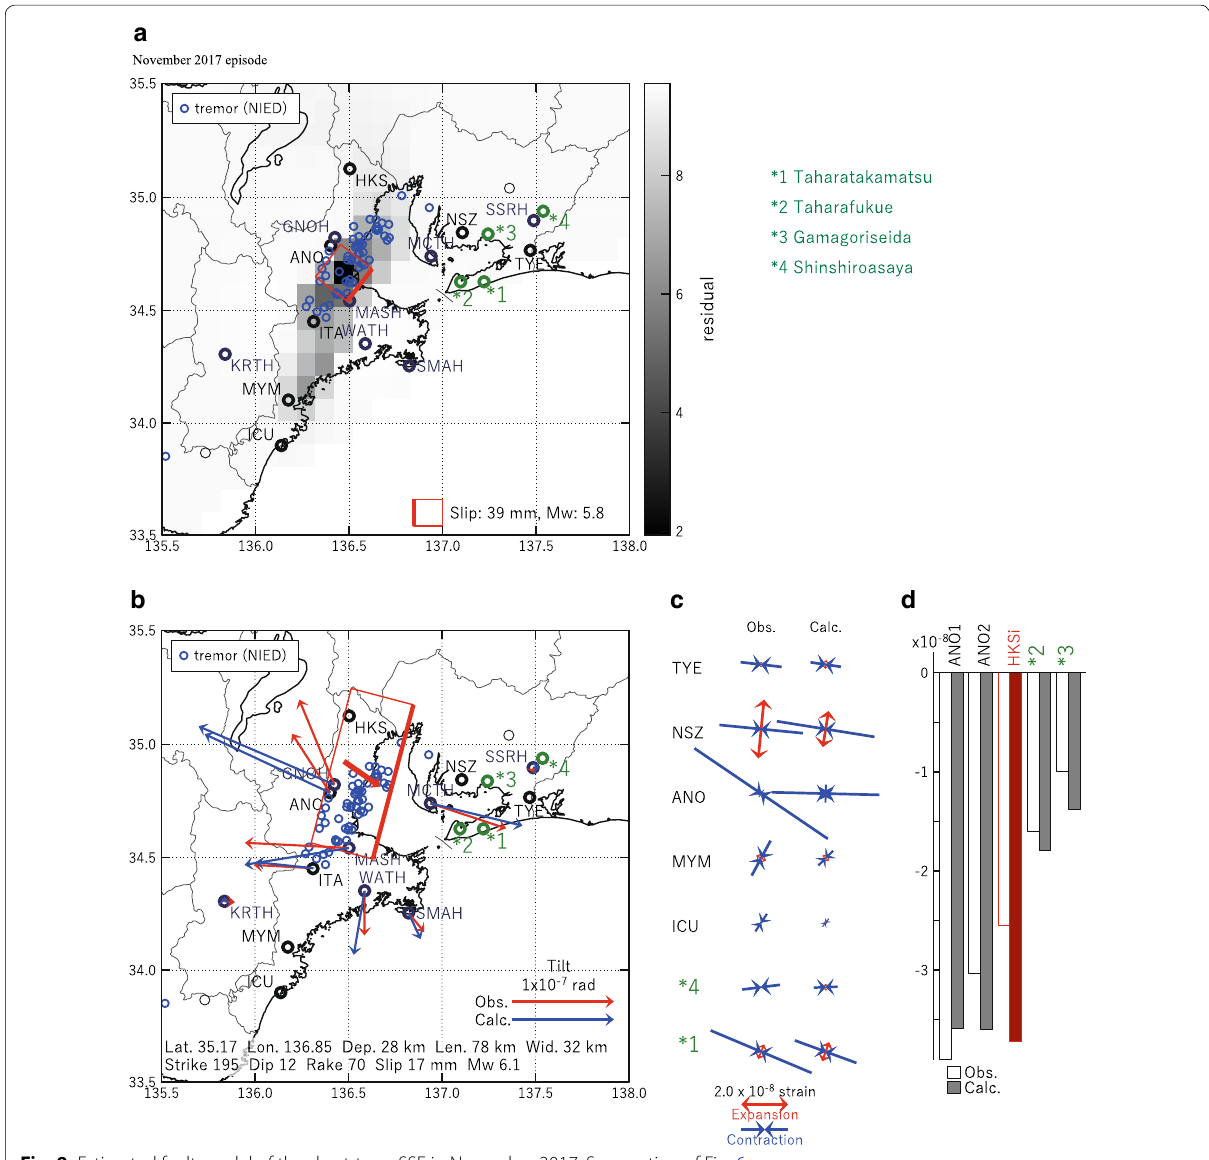
Fig. 9 Estimated fault model of the short-term SSE in November 2017. See caption of Fig.